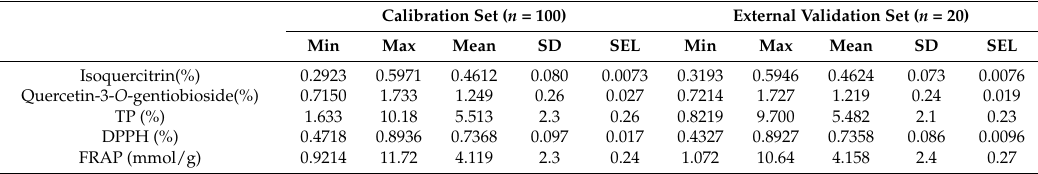
Table 1. Reference data of okra seed samples in calibration and validation